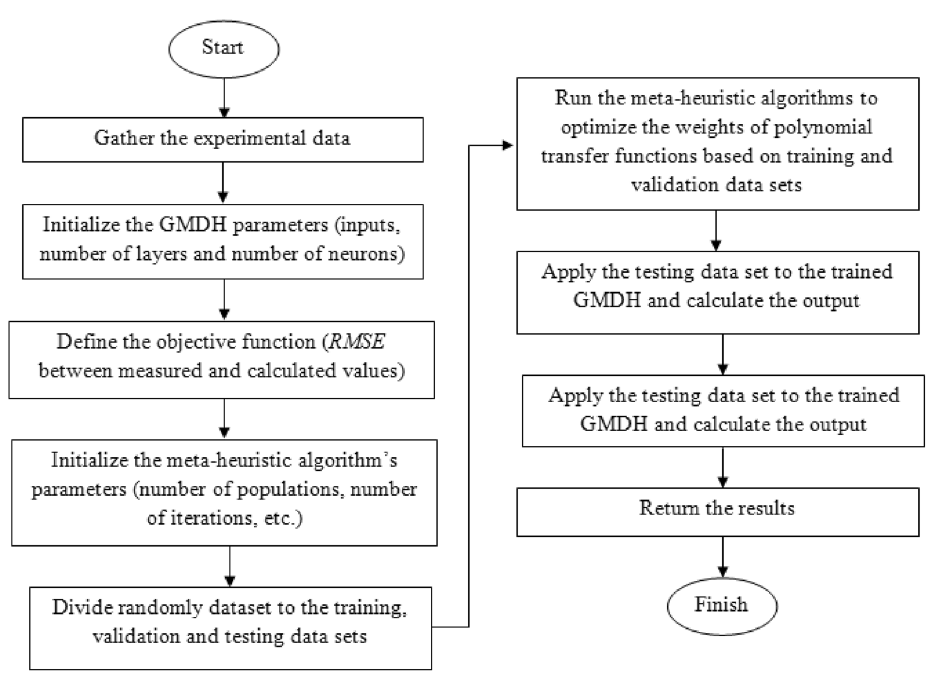
Figure 2. GMDH- HGSO and GMDH- EO